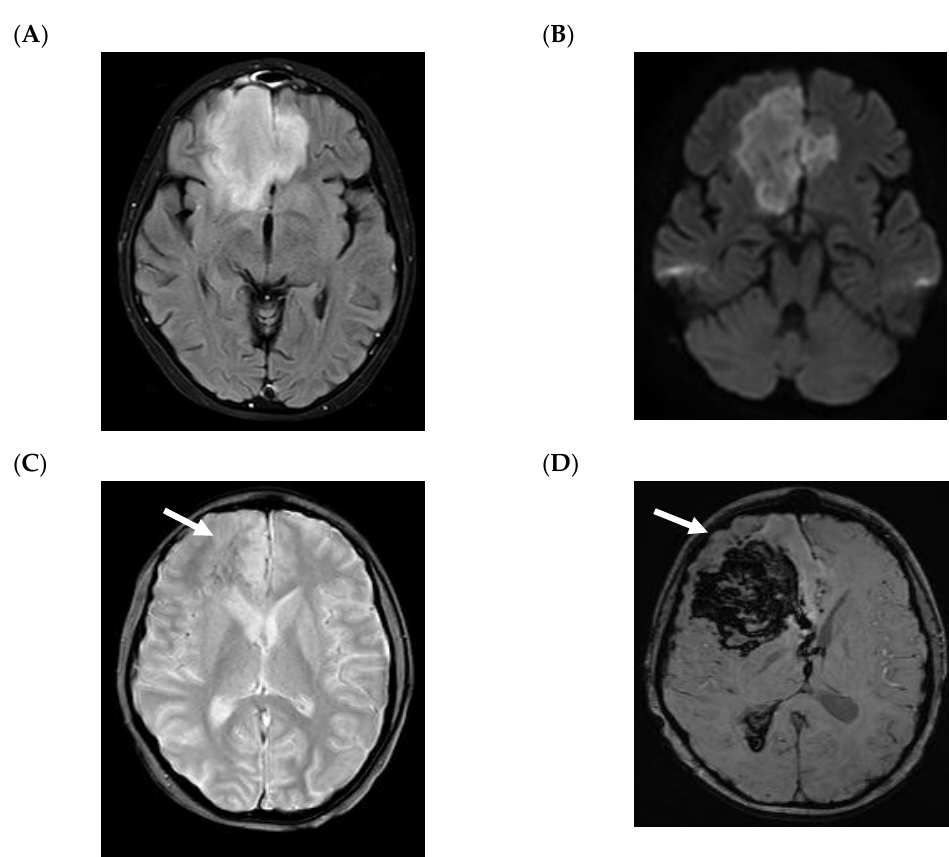
Figure 2. A 12-year-old boy with acute lymphoblastic leukemia with frontal cerebritis in the right and left frontal lobe and probable central nervous system (CNS) invasive mold infection. Aspergillus fumigatus and Rhizopus arrhizus were isolated outside the CNS. The patient is alive with residual left-sided hemiparesis. A, B and C: Imaging performed during the early stage of frontal cerebritis, mainly on the right side. Fluid-attenuated inversion recovery (FLAIR) image shows hyperintense white matter of frontal lobe ( A ). Diffusion-weighted image (DWI), b = 1000 s/mm 2 , shows diffusion restriction in the area of frontal cerebritis ( B ). T2* image ( C ) shows an ill-defined hypointense area (arrow). No enhancement was seen. After 20 days, magnetic resonance imaging was performed after clinical worsening and suspected vascular involvement ( D ). Susceptibility-weighted image (SWI; D) shows marked decreased signal intensity and blooming with mass effect. Findings were consistent with major secondary hemorrhage (D, arrow) and intraventricular bleeding.